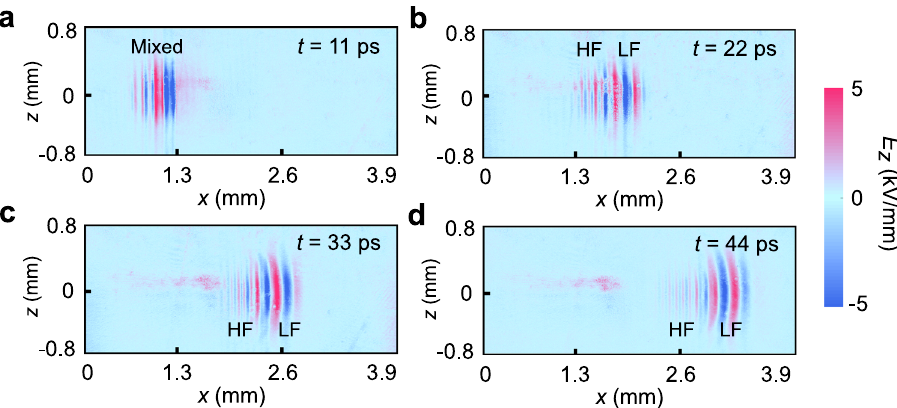
Fig. 3 Direct observation of the DFG process for THz waves. a – d are snapshots from Supplementary Movie 1 taken at 11, 22, 33, and 44 ps after the THz waves were initially generated. LF and HF indicate the lower and higher frequency components, and their walk-off effect during propagation is clear.